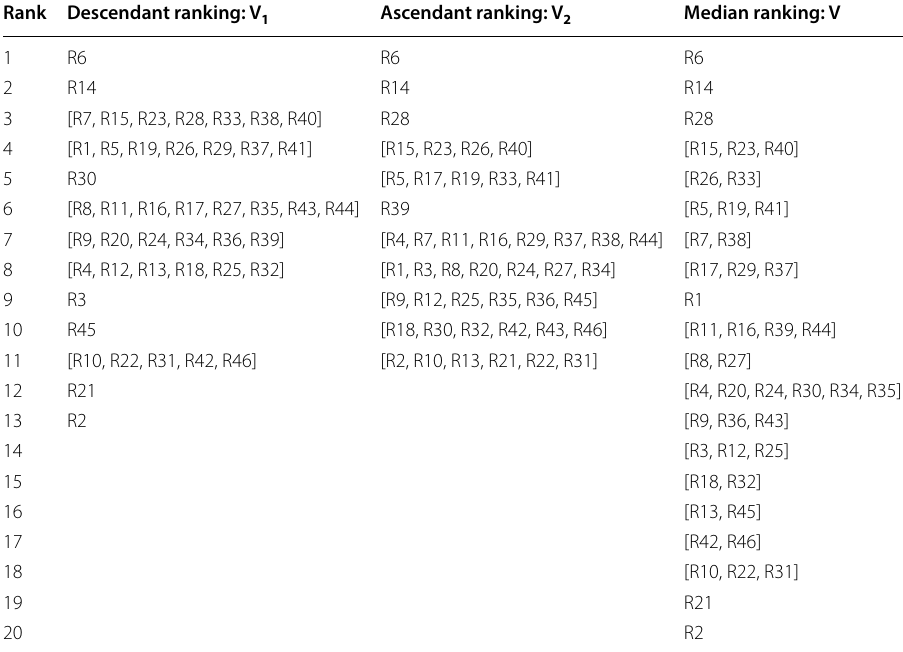
Table 8 ELECTRE II method, descendant, ascendant, median and final ranking Rank Descendant ranking: V